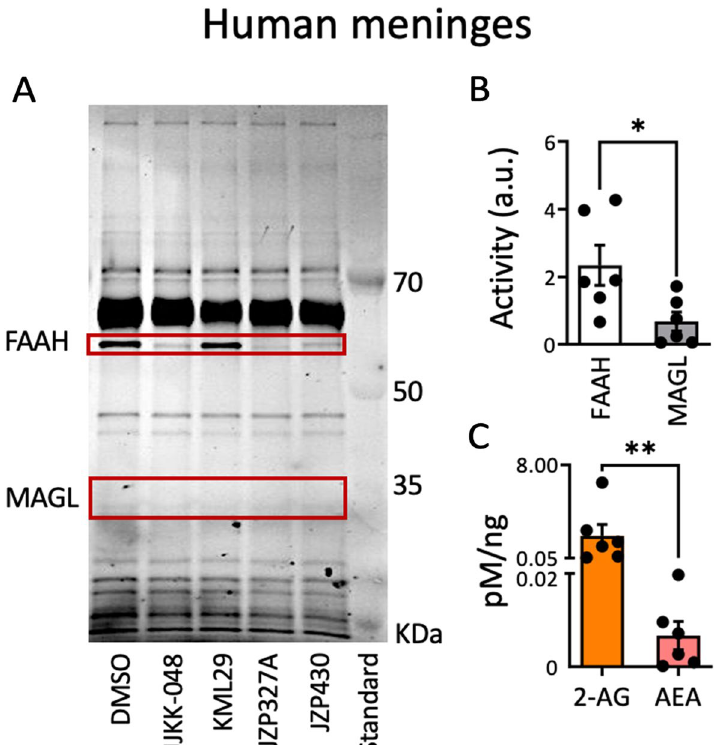
Fig. 2 Competitive gel‑based ABPP reveals high FAAH over MAGL activity in human dura mater. A Human dura mater was pre‑incubated for 1 h with DMSO (vehicle), MAGL‑inhibitors JJKK‑048 (100 nM) and KML‑29 (1 μM) and FAAH‑inhibitors JZP‑327A (1 μM) and JZP‑430 (1 μM), and then labelled with fluorescent probe TAMRA‑FP, as indicated in the Methods. TAMRA‑FP‑labelled bands appear dark after in‑gel imaging. FAAH and MAGL were identified based on selective inhibition and their expected molecular weights. MAGL and FAAH band‑intensities after DMSO treatment represent basal MAGL and FAAH activities, respectively. Note that FAAH activity after DMSO treatment is high whereas basal MAGL activity is practically absent. Basal FAAH‑ activity appears reduced with JZP‑327A and with JZP‑430. MAGL‑inhibitor, JJKK‑048 (100 nM), decreased FAAH basal activity as off‑target. B Statistics comparing the basal activity of MAGL and FAAH in human meninges. FAAH basal activity (DMSO) was found higher than MAGL activity ( N 6, Mann Whitney U test, * 0.033). C LC–MS/MS data comparing AEA and 2‑AG levels in naïve human meninges. The level = = of 2‑AG was much higher than that of AEA ( N 6, Mann Whitney U test, ** = =